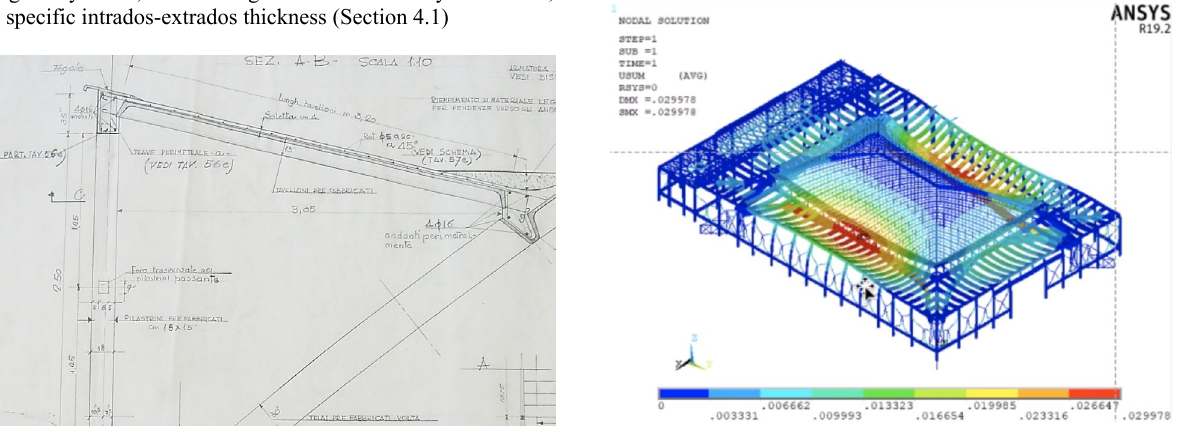
Figure 12. The static analysis on the numerical model based on the original documentation, with indication of max displacement (red).